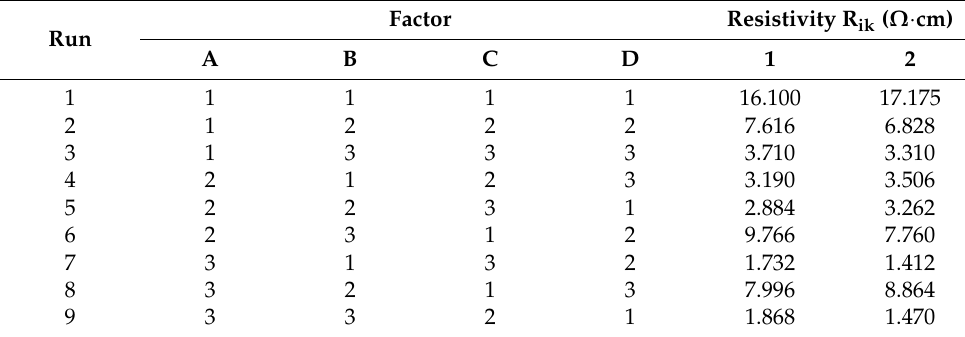
Table 2. Orthogonal experiment plan and results.